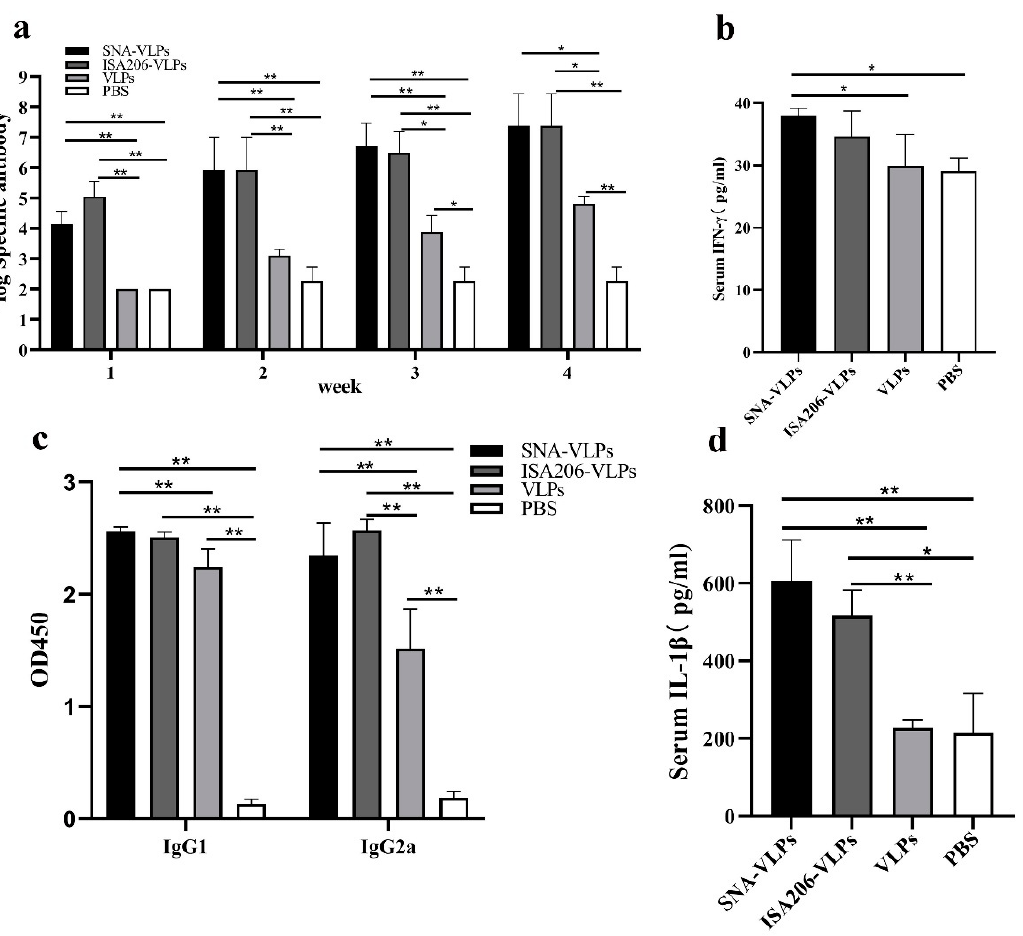
Figure 6. Results of the immunization experiments in mice. ( a ) Specific antibody levels in the mice immunized with various vaccines. ( b ) IFN- γ levels in serum. ( c ) Levels of IgG1 and IgG2a. ( d ) IL-1 β levels in serum. * p < 0.05, ** p <